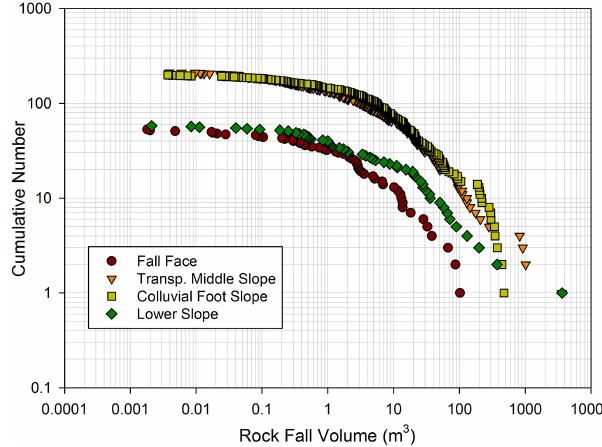
Figure 6. Cumulative frequency curves of rockfall